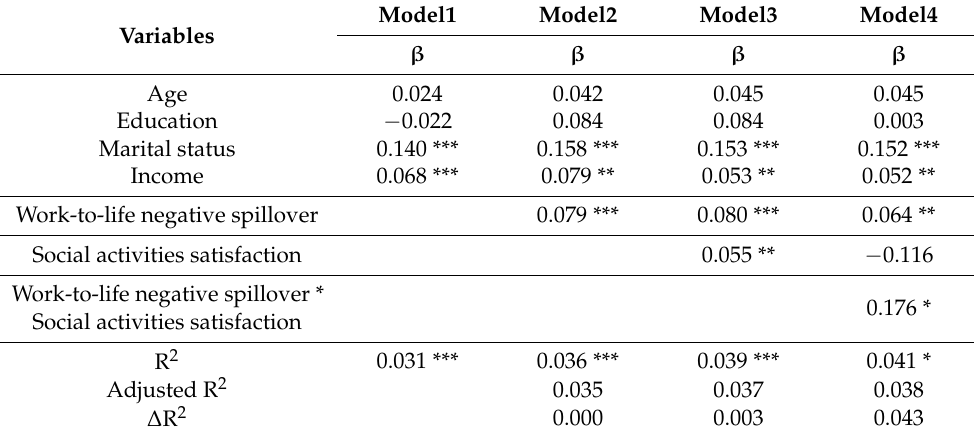
Table 4. Moderating effects of social activities satisfaction between work-to-life negative spillover and